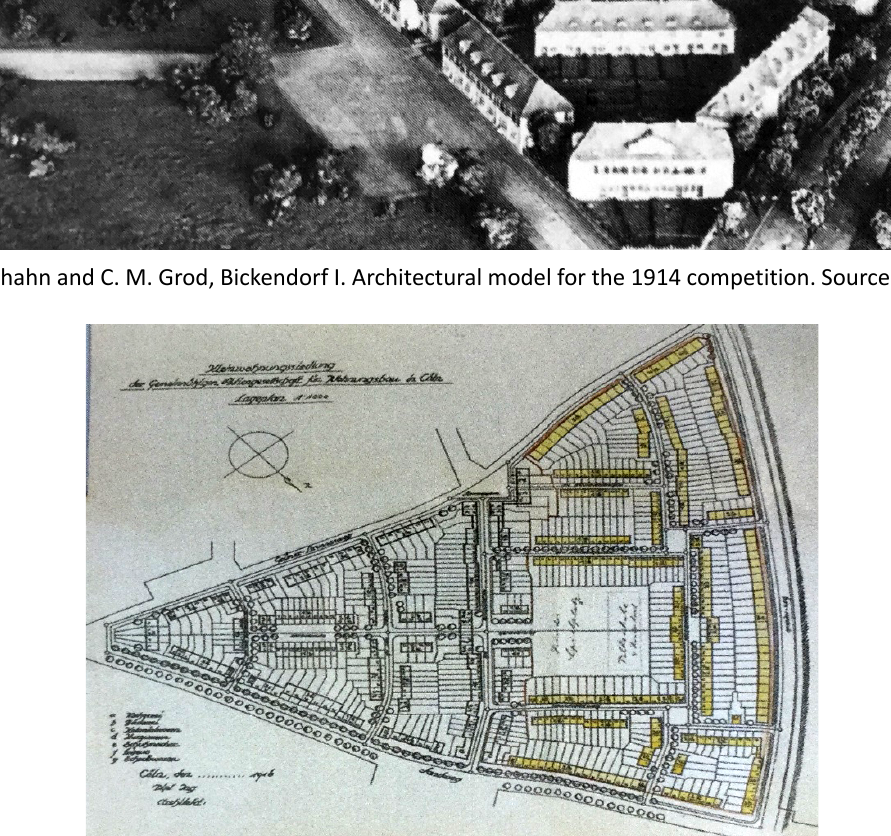
Figure 7. W. Riphahn and C. M. Grod, Bickendorf I. Plan (April 1919). Source: Riphahn’s private archive,